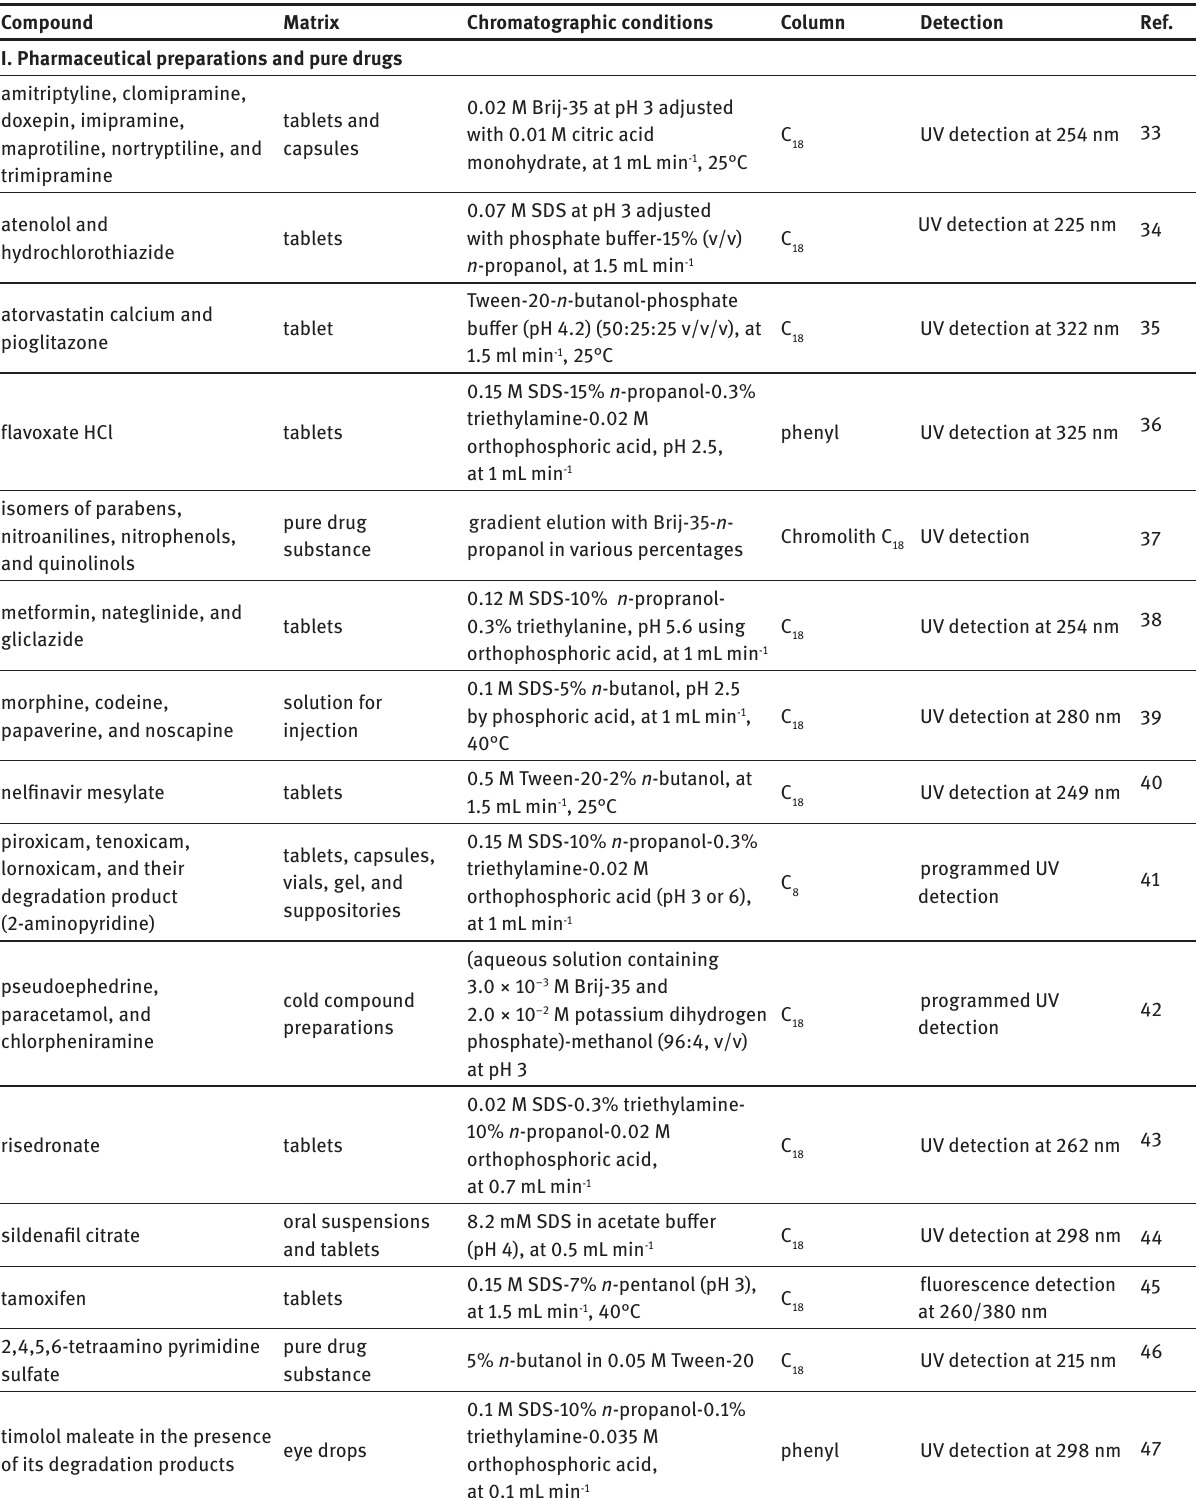
Table 2: Recent applications of MLC in different matrices